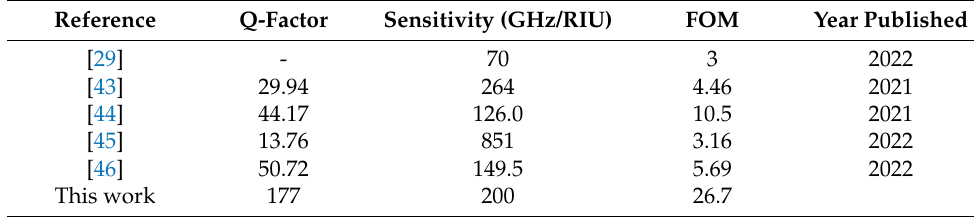
Table 2. Comparison of sensor